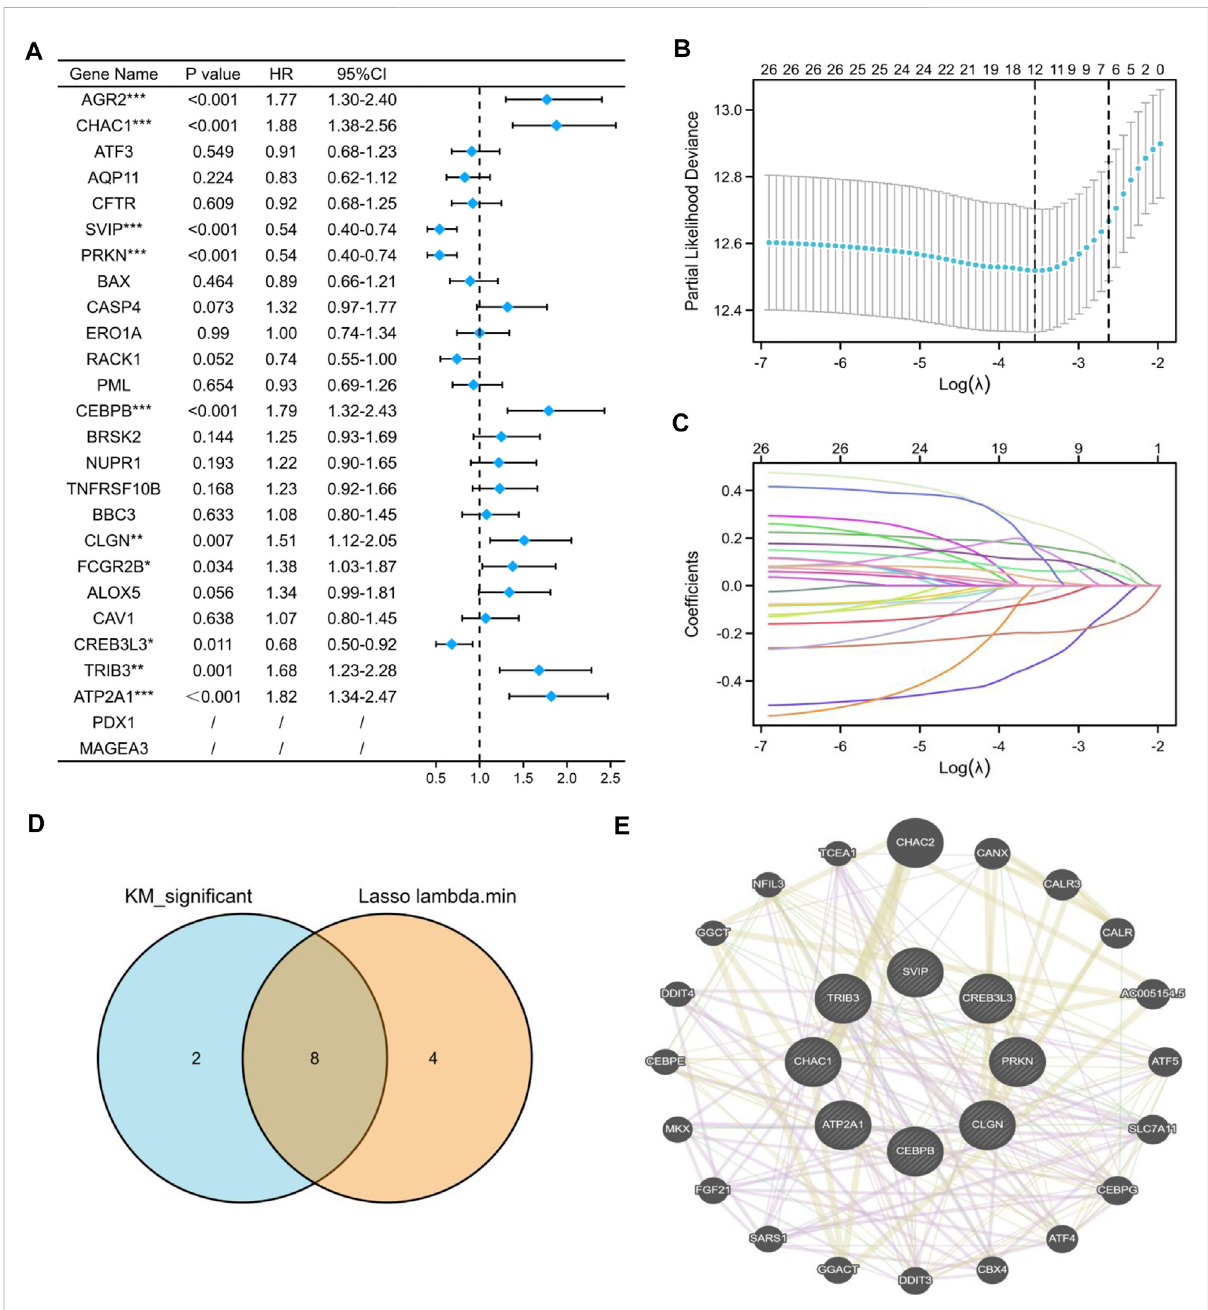
FIGURE 5 Construction of the prognostic model based on ER stress-related DEGs. (A) Univariate Cox regression analysis of 26 ER stress-related DEGs. (B,C) LASSOcoef fi cientpro fi lesof26 ERstress-relatedDEGs. (D) VenndiagramvisualizedtheintersectinggenesbetweentheK-M-relatedDEGsand lambda minimum genes. (E) GGI analysis by the GeneMANIA website among candidate ER stress-related DEGs. (* p < 0.05, ** p < 0.01, and *** p <